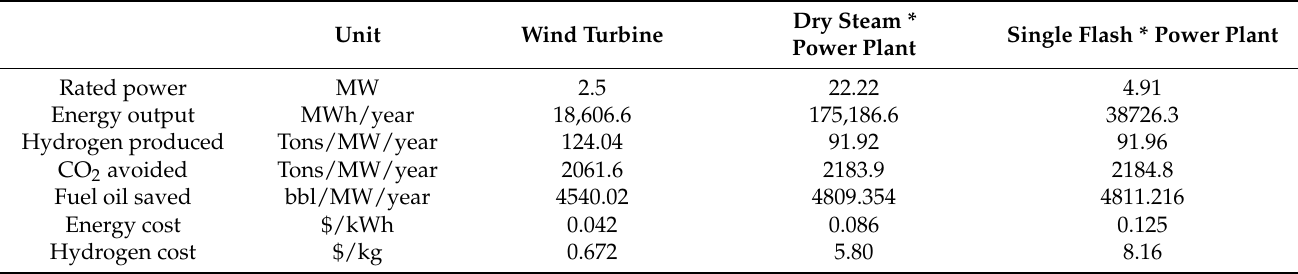
Table 6. Comparative analysis of hydrogen production from wind and geothermal energy using PEME